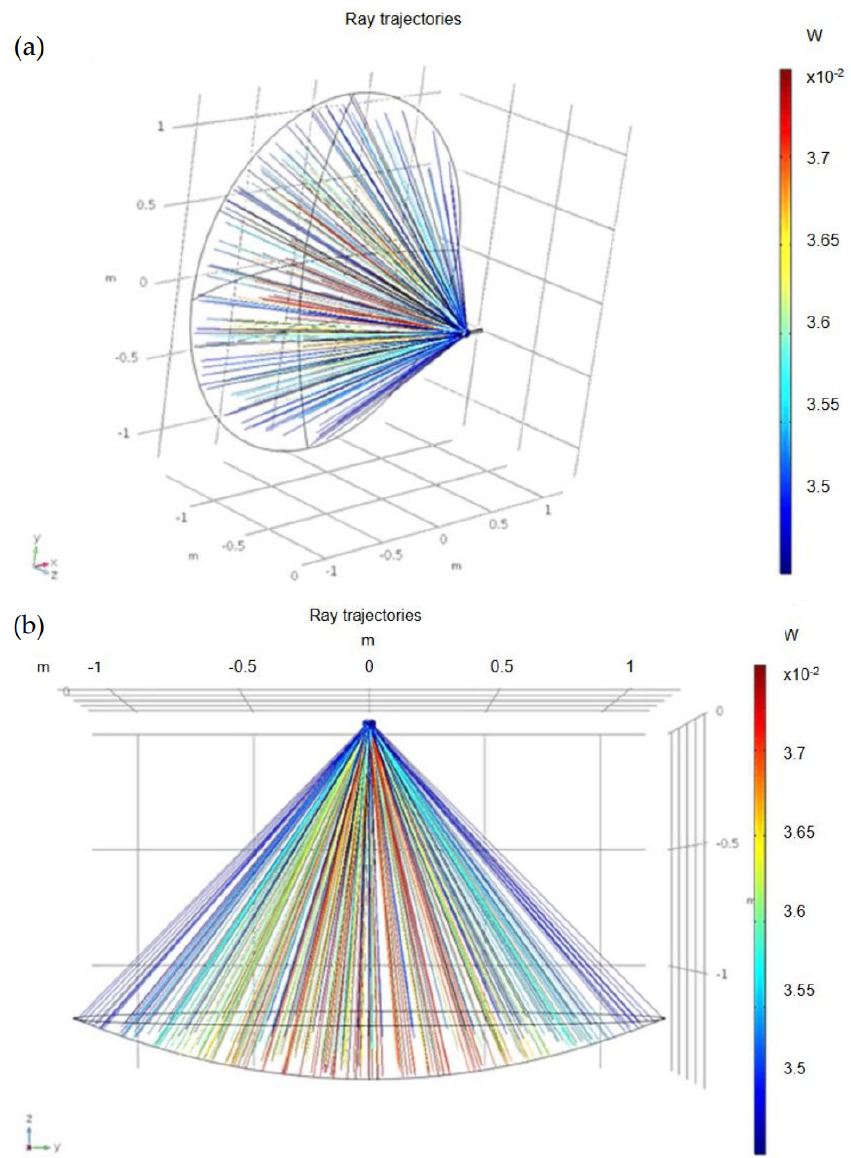
Figure 6. ( a ) Profile view of trajectories of reflected rays. ( b ) Trajectories of reflected rays in terms of deposited power.